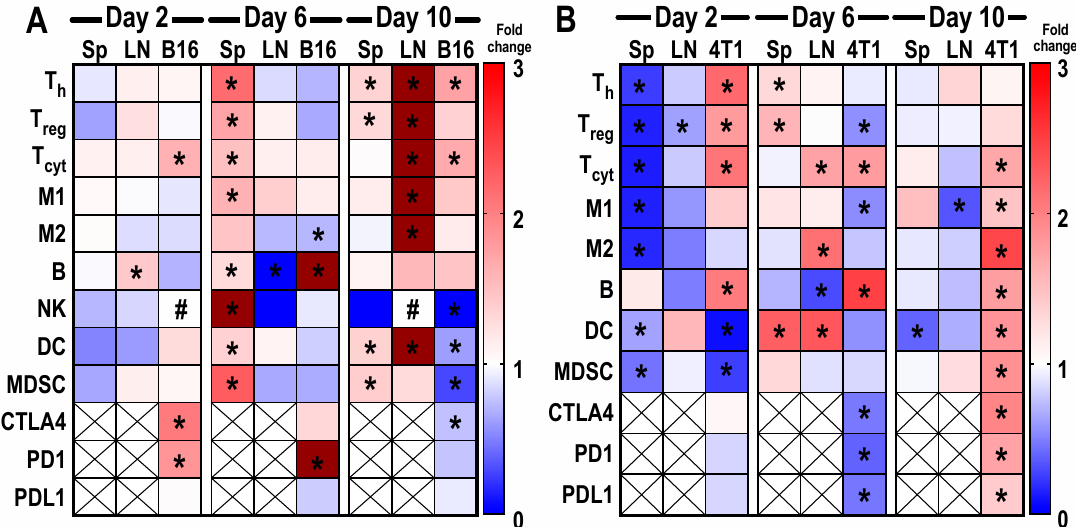
Figure 3. Heat maps depicting fold changes of immune cell profiles and checkpoint receptor / ligands from mice with B16 melanoma ( A ) or 4T1 breast ( B ) tumor, spleen (Sp), and lymph node (LN) that were harvested 24 h following pFUS treatment on days 1, 5, or 9. Day 1 tumors were ~5 mm in size. Non-sonicated tumors harvested on day 2, 6, or 10 served as time-matched controls. Flow cytometry analysis was performed by staining fresh fixed immune cells (CD8 + T cyt , CD4 + T h , T reg , natural killer (NK) cells, dendritic cells (DCs), F4 / 80 macrophages (M1 and M2), myeloid suppressive cells along with cytotoxic T-lymphocyte associated protein 4 (CTLA4), programmed cell death protein 1 (PD1), and programmed death ligand 1 (PDL1)) in the tumors. Blue represents fold changes less than 1. Red represents 1–3 fold changes. Dark red represents fold changes higher than 3. Asterisks indicate statistical significance ( p < 0.05) identified by ANOVA test. Pound indicates undetected values.